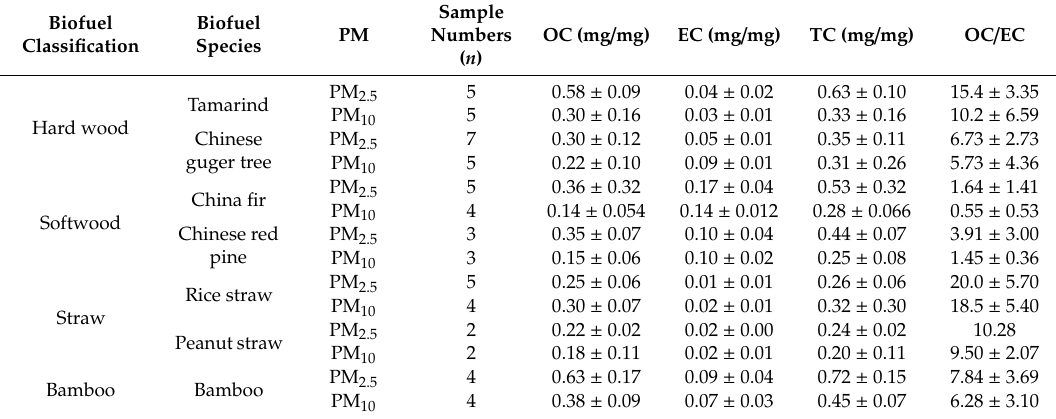
Table 2. OC, EC and total carbon (TC) mass ratios and OC / EC ratios in PM 2.5 and PM 10 emitted by combustion of di ff erent biofuel